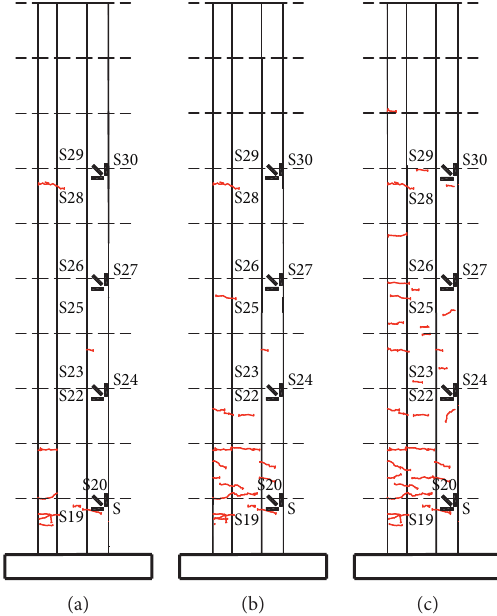
Figure 22: Crack evolution on concrete wall of axis A. (a) SN � 29. (b) SN � 41. (c) SN �